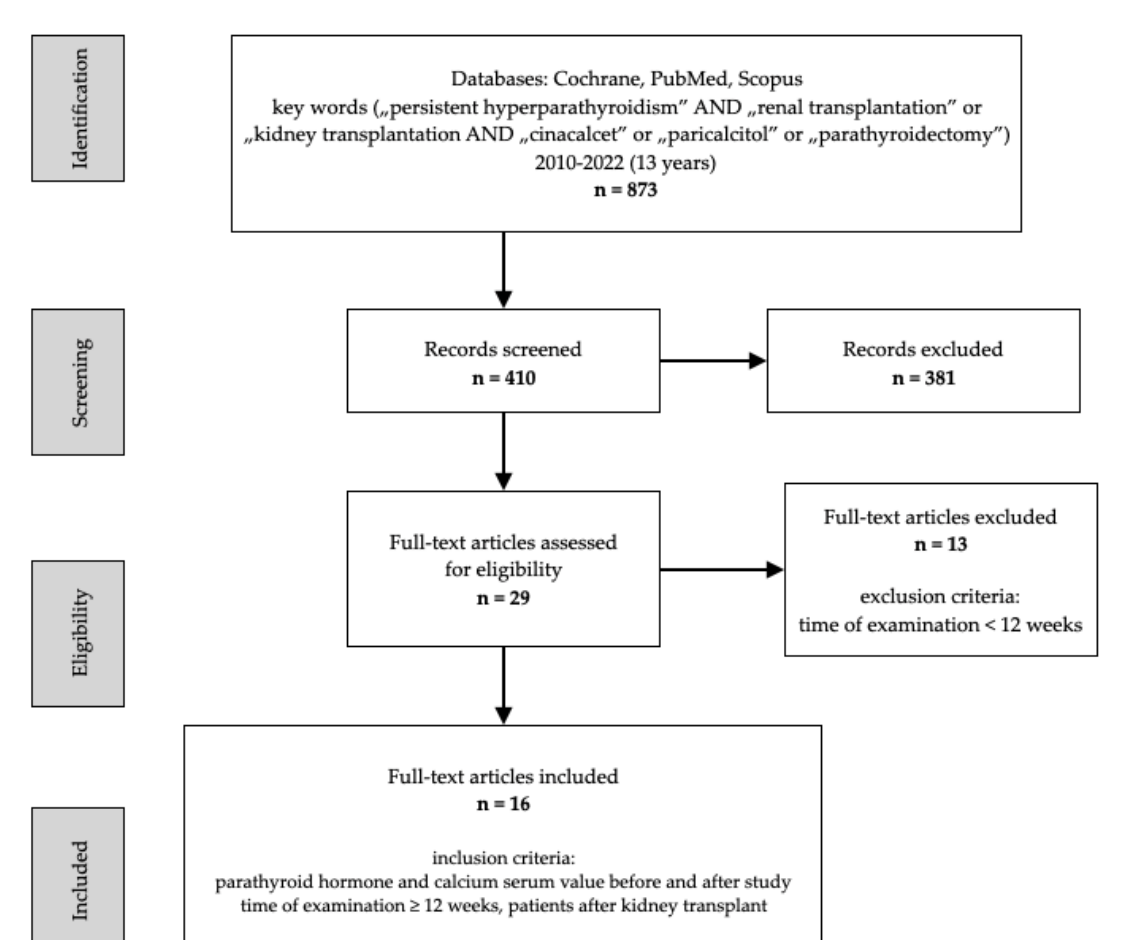
Figure 1. Stages of including articles in the review, PRISMA flowchart.